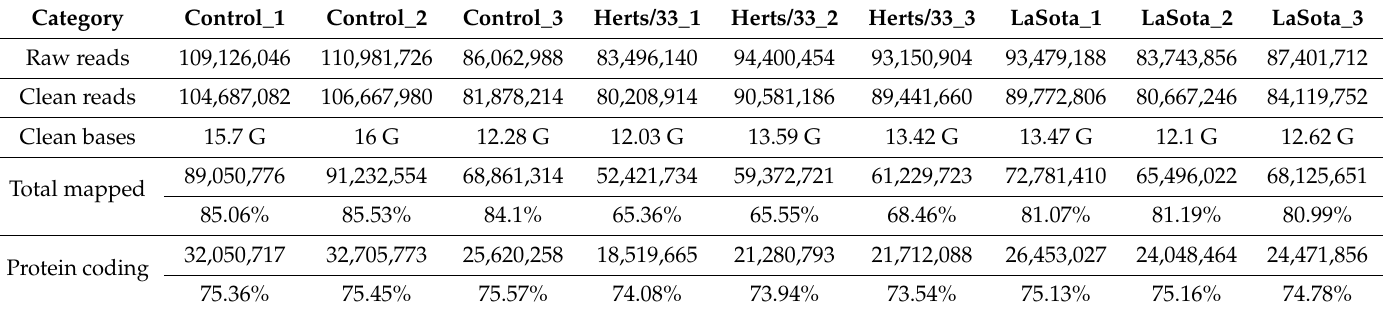
Table 2. Summary of sequences analysis.